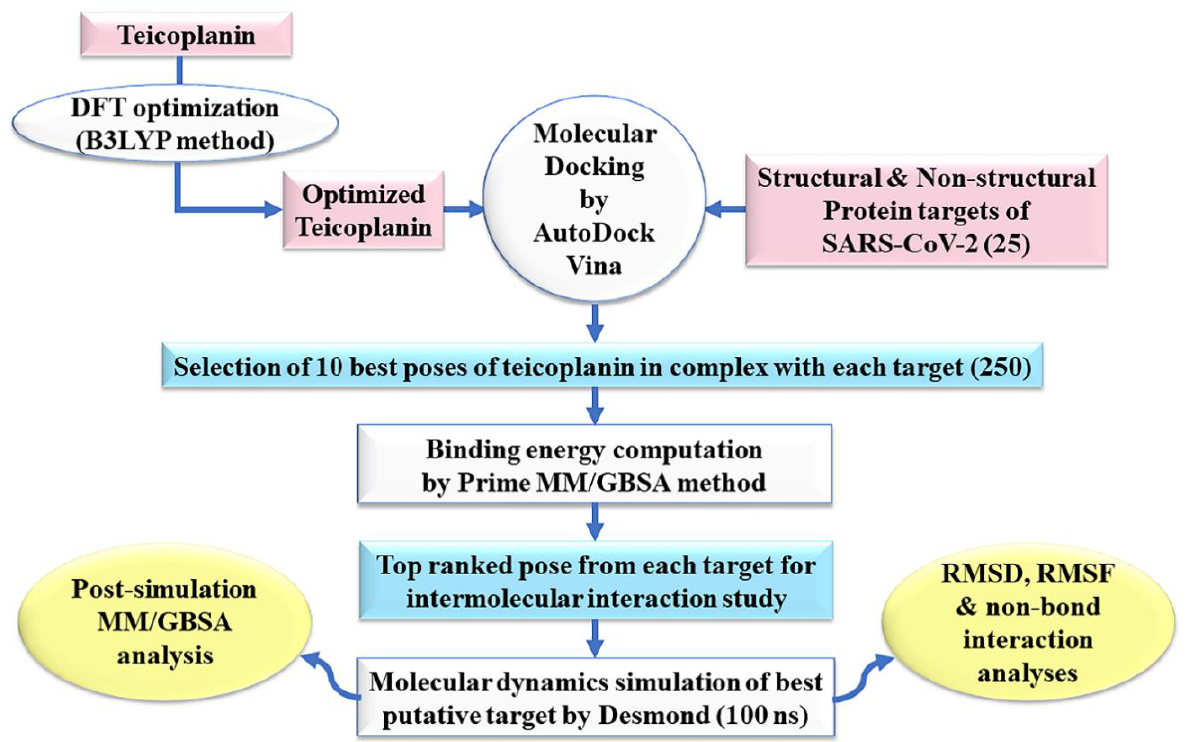
Figure 2. An outline of the adopted methodology in this study. B3LYP: Becke’s three-parameter hybrid model, Lee–Yang– Parr correlation functional method; DFT: density functional theory; MM/GBSA: molecular mechanics/generalized Born surface area; ns: nano seconds; RMSD: root-mean-square deviation; RMSF: root-mean-square fluctuation.